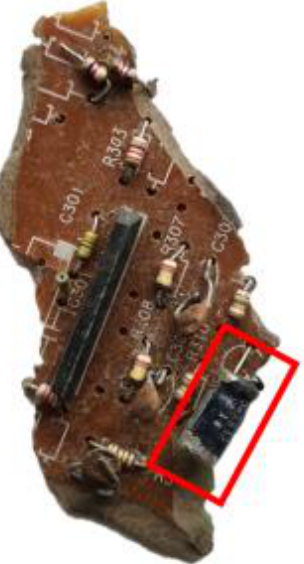
Figure 14. Result of classification for PCBs using 3D features (after step 3). Classification of four different types of components on board (ecob 4, ecob 5, ecob 6 and ecob 7).